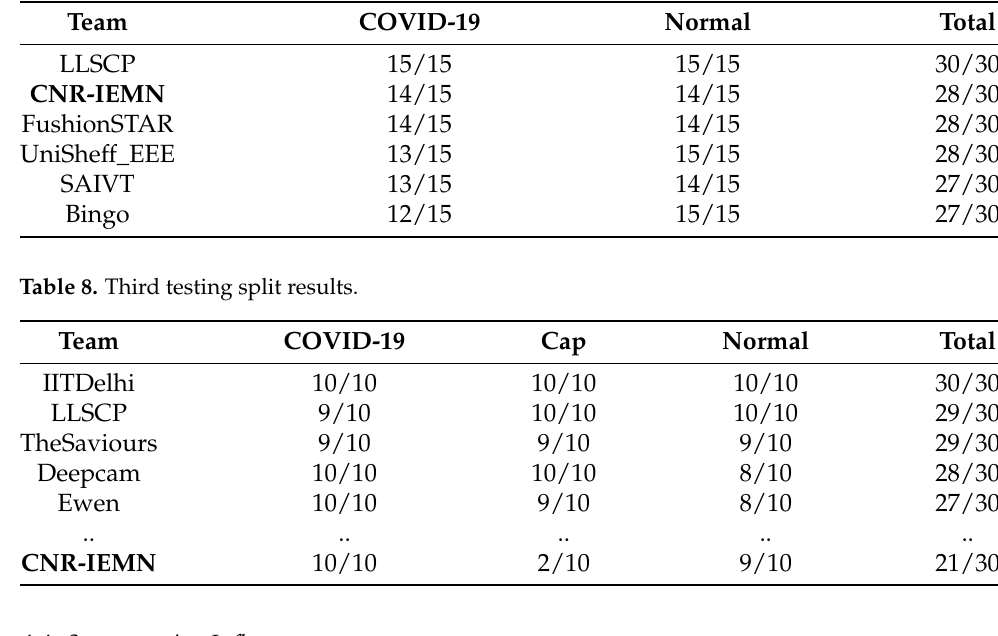
Table 7. Second testing split results.